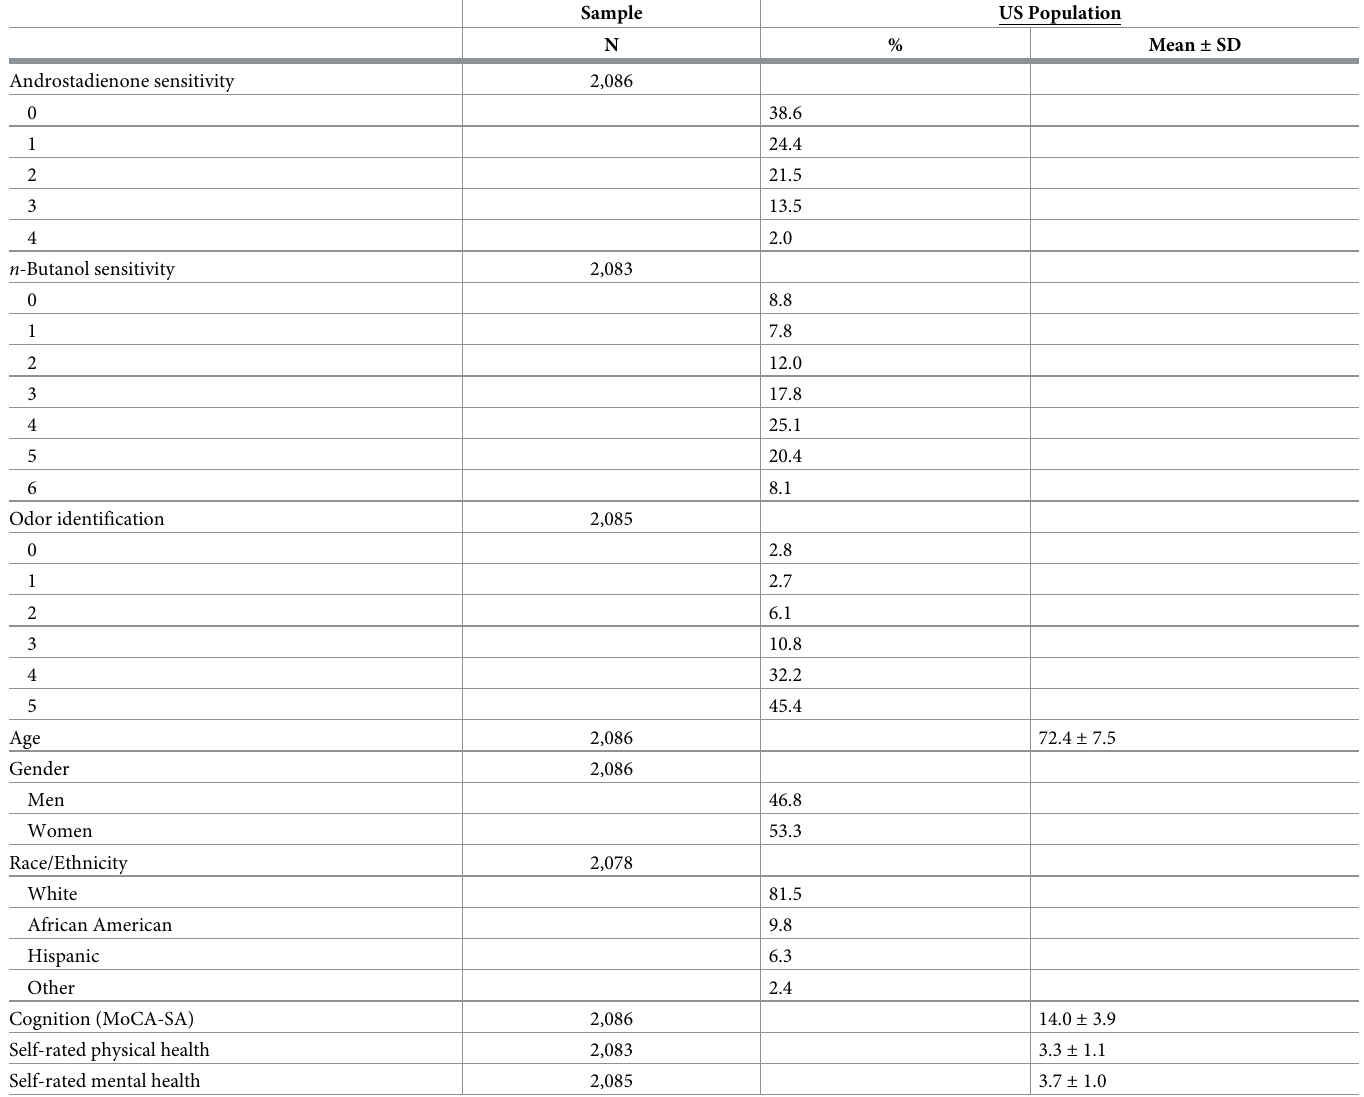
Table 1. Distributions of olfactory function (# correct), demographics, cognitive function and health of older US adults living at home (NB: Tables are large and at the end of the